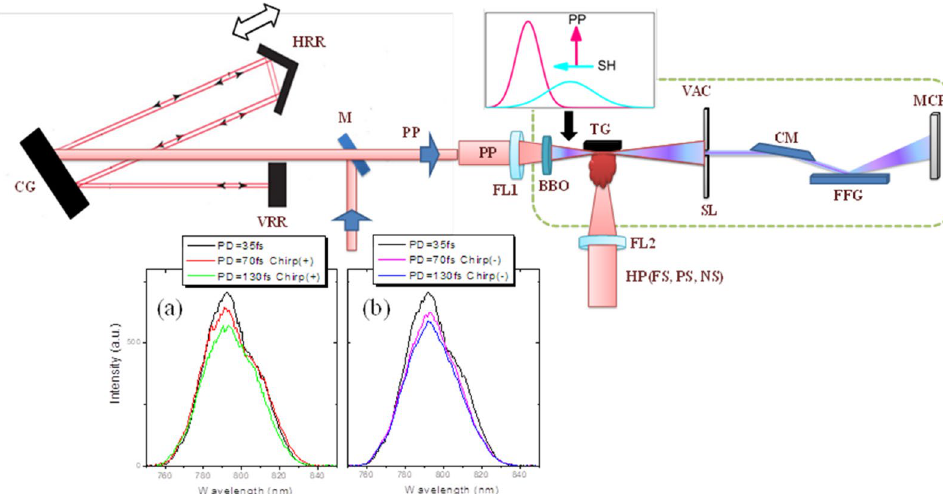
Figure 1. The schematic view of HHG setup. The uncompressed laser pulse was directed by a mirror (M) to the compressor comprising of the compressing grating (CG), vertical retroreflector (VRR), and horizontal retroreflector (HRR). The compressed probing pulse (PP) was focused by a focusing lens (FL1) inside the vacuum chamber (VAC) comprising the target and XUV spectrometer. The focused pulses propagated through the 0.2 mm thick BBO crystal to generate second harmonic (SH) for the two-color pump of plasma. Inset shows the relative positions of the SH (blue curve) and PP (red curve) pulses and their polarizations. The heating pulses (HP) were focused by a focusing lens (FL2) to produce the laser plasma on the surface of the target (TG). The generated harmonics and fundamental radiation propagated through the slit (SL) and entered the XUV spectrometer comprising of the cylindrical mirror (CM), flat-field grating (FFG), and micro-channel plate (MCP). Bottom panels: The spectra of ( a ) chirp-free 35 fs pulses and positively chirped 70 and 130 fs pulses and ( b ) chirp-free 35 fs pulses and negatively chirped 70 and 130 fs pulses. PD, pulse